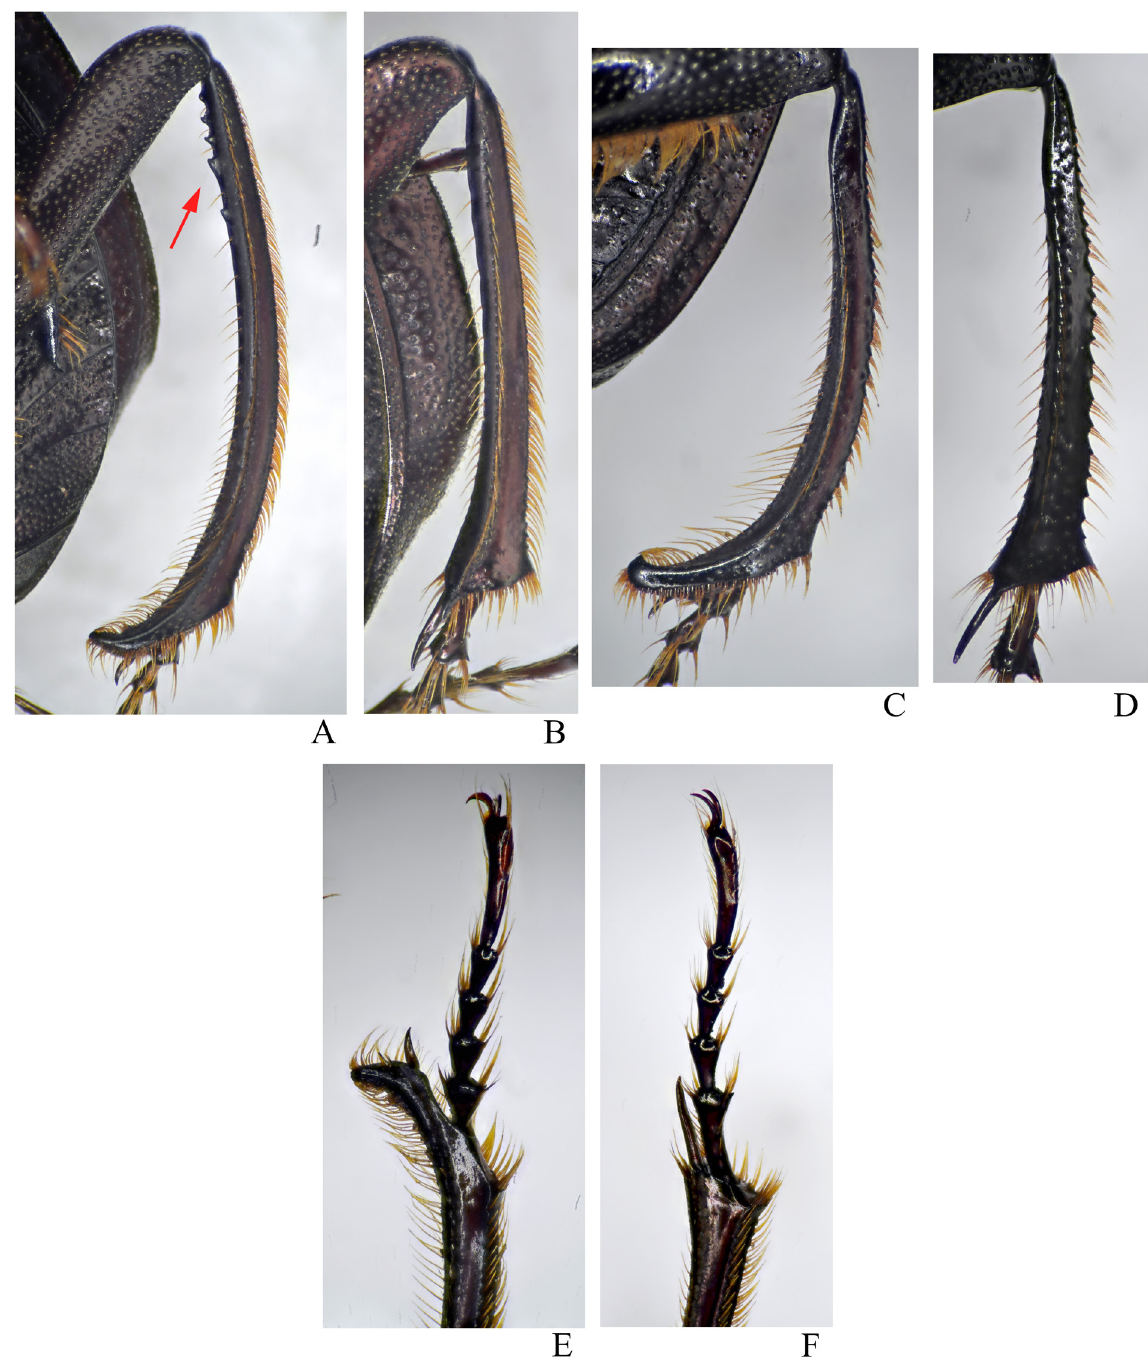
Fig. 20. Posterior legs. A‒D . Metatibiae. A‒B . Streblopus opatroides van Lansberge, 1874. A . ♂. B . ♀. C‒D . S. punctatus (Balthasar, 1938). C . ♂. D . ♀. Note the strong sexual dimorphism and